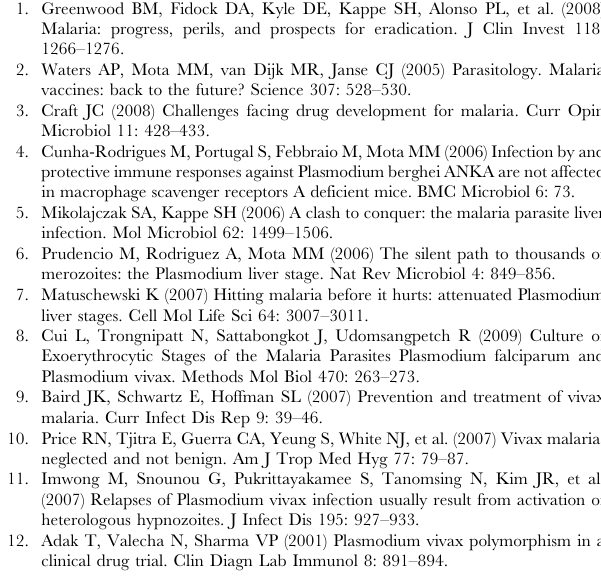
Supplementary Figure S5 A. Source reconstruction of 3D whole body imaging of three mice at 44 h after infection by bites of 5–10 infected mosquitoes. Eleven luminescent sources are detected in mouse 3 (M3), one in mouse 5 (M5) and none in mouse 4 (M4). See also Supplementary Movies 2 and 3 corresponding to mouse 3 and 5 respectively. B. 2D-imaging of the extracted livers of the mice shown in panel A. Livers were imaged at both sides using the IVIS Spectrum system. Numbers in the images represent the number of luminescent spots identified. Rainbow images show the relative level of luminescence ranging from low (blue), to medium (green), to high